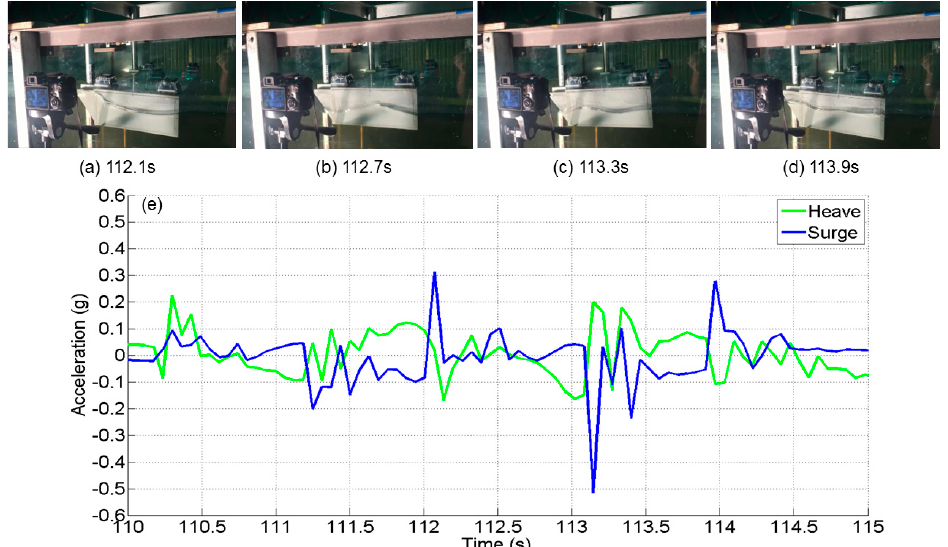
Figure 6. Time slice of Narrow Pontoon during the 2 s wave test. ( a – d ) Snap shots of pontoon motion and Sensor 1 heave and surge accelerations.